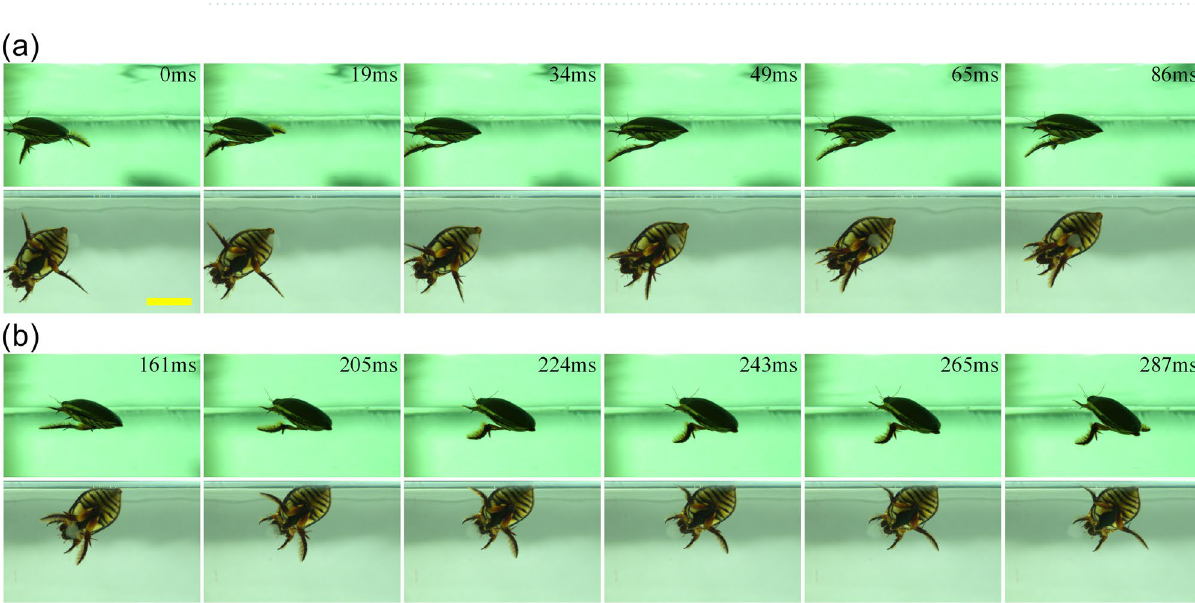
Figure 2. Time sequence diagram of a diving beetle for one right-turning cycle: the entire cycle of turning to the right is 312 ms, (a) the power stroke, (b) the recovery stroke, the scale bar = 20 mm, the top image of the diving beetle in the ventral view is the reflection in the water.